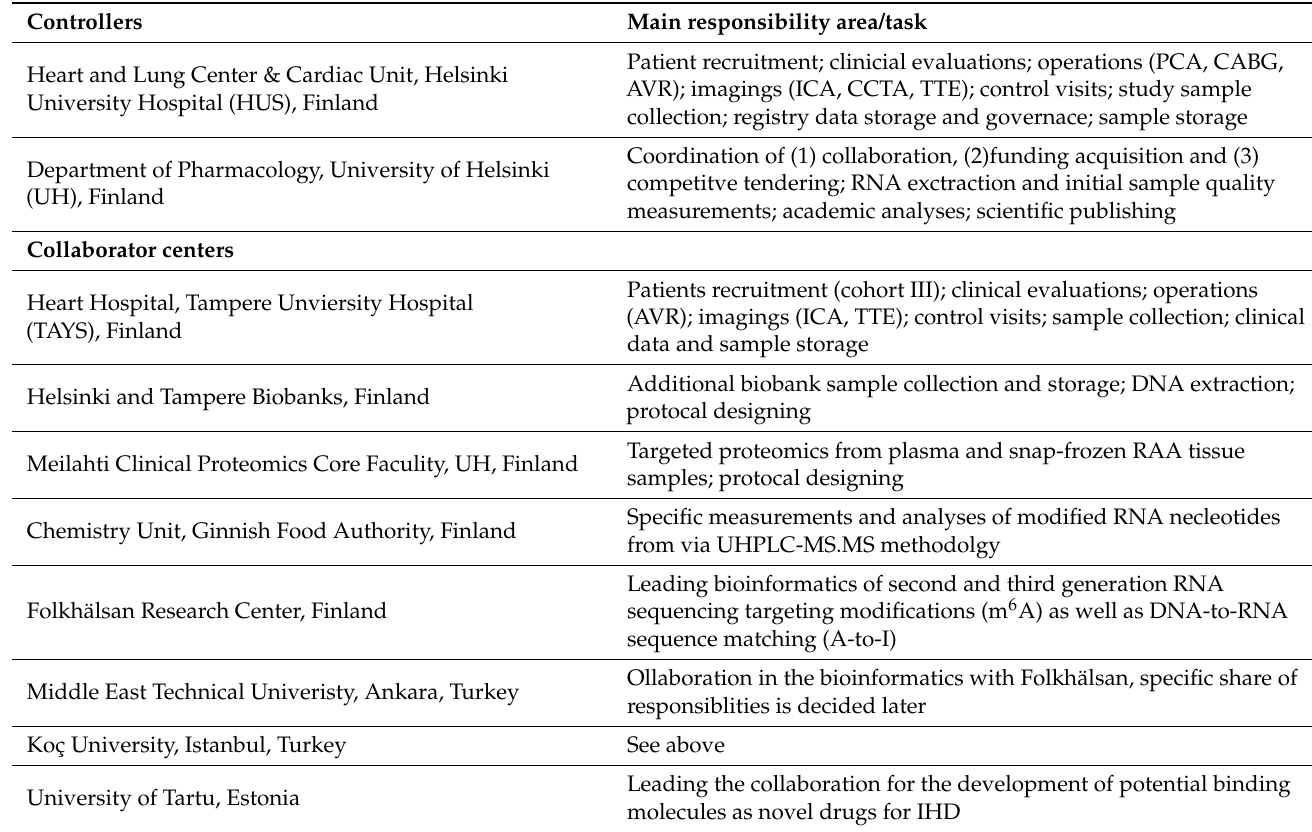
Table 4. Current controller and collaborator centers of the IHD-EPITRAN study with respective main responsibilities. A-to-I , Adenosine-to-inosine RNA editing; AVR , Aortic valve replacement surgery cohort III; AVS , aortic valve stenosis; CABG , coronary artery bypass surgery cohort II; CCTA , coronary computed tomography angiogram cohort IV; ICA , invasive coronary angiography; meRIP-seq , methylated RNA immunoprecipitation sequencing; m 6 A , N 6 -methyladenosine; PCI , percutaneous coronary intervention; TTE , transthoracic